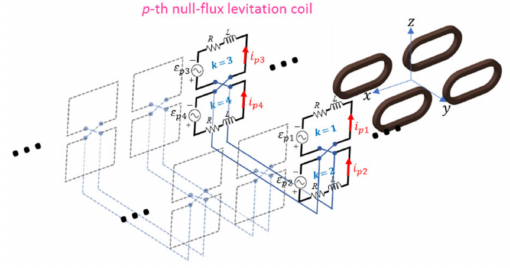
Figure 8. Null-flux levitation coil consisting of connections of RL circuits of four